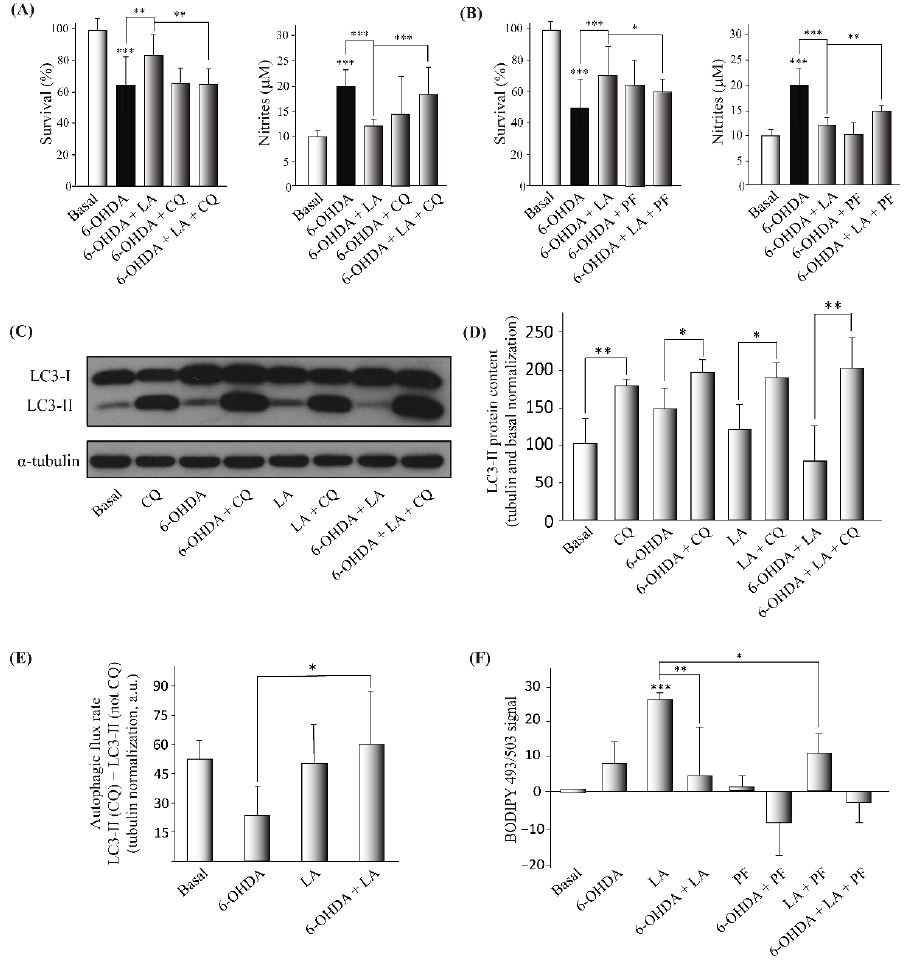
Figure 4. Regulation of the autophagic flux and lipid droplet levels by LA in the SH-SY5Y PD model. The human cell line SH-SY5Y was exposed to 35 μ M 6-OHDA in the presence or not of LA, PF, and CQ. ( A , B ) Cell viability was measured by MTT assay, with LA, 6-OHDA, CQ, or PF added or not. The nitrite concentration was evaluated by Griess reaction under same conditions. Each bar represents the mean ± SD of three independent experiments with 6 replicates per experimental group. Data were analyzed using one-way analysis of variance (ANOVA) followed by the Games– Howell correction in some cases and the Kruskal–Wallis test followed by Dunn’s multiple comparisons test in other cases. *** p < 0.001, ** p < 0.01, * p < 0.05. ( C , D ) Representative Western blot and quantification showing the expression of LC3-II normalized by tubulin and by the control levels (%). Data represent the results of three independent experiments, and the error bars correspond to ± SD. Data were analyzed using one-way analysis of variance (ANOVA) followed by the Games– Howell correction. * p < 0.05 and ** p < 0.01 (if not indicated, it is with respect to the control). ( E ) The graph shows the autophagic flux rate (arbitrary units) of the different experimental groups. These measurements represent the subtraction of the LC3-II levels (arbitrary units normalized by tubulin) experiments. Data were analyzed using the ANOVA test followed by Tukey’s multiple comparisons test. * p < 0.05 in comparison with 6-OHDA. ( F ) Determination of the BODIPY 493/503 signal was done by flow cytometry in the SH-SY5Y cell line treated or not with LA, 6-OHDA, and/or PF. The graph shows the mean value of the BODIPY 493/503 signal for the different treatment groups normalized by the control group. The results correspond to 6 independent experiments per group, and the error bars show ±SD. Data were analyzed using the Kruskal–Wallis test followed by Dunn’s